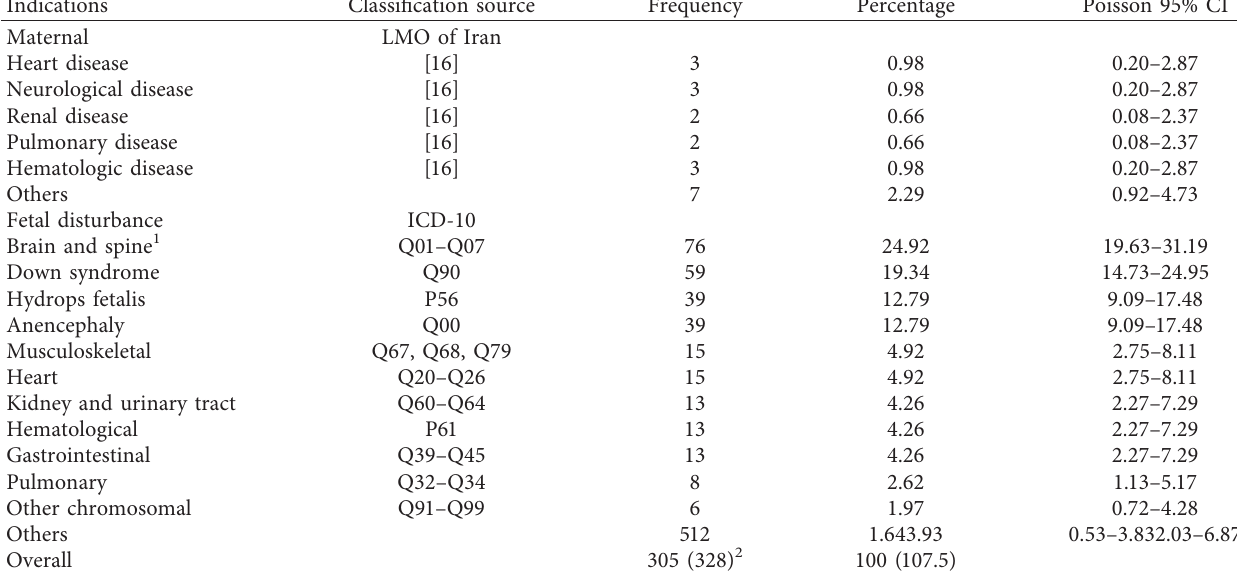
Table 3: Distribution of maternal and fetal reasons of legal